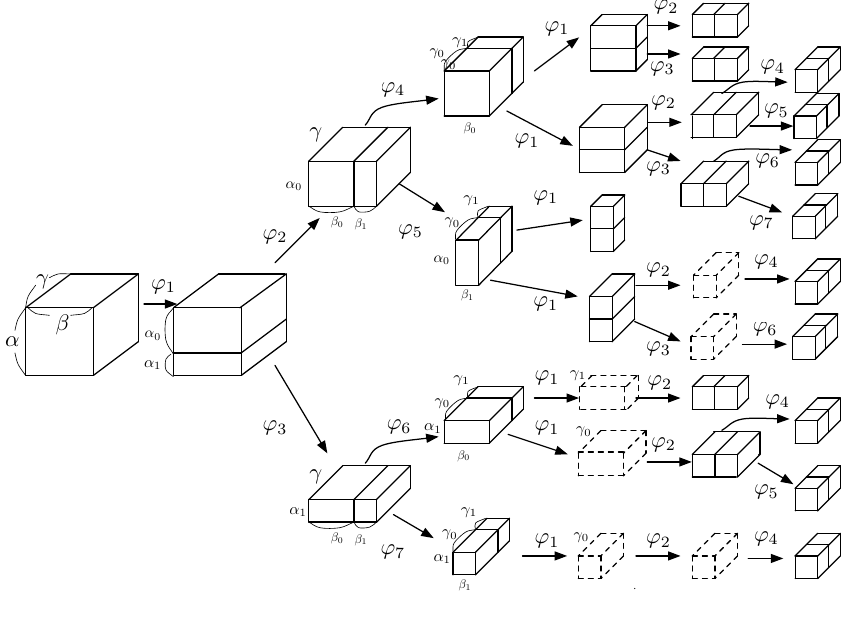
Figure 3. Three-dimensional orthonormal tree-structured Haar transform (3D-OTSHT) basis blocks built by